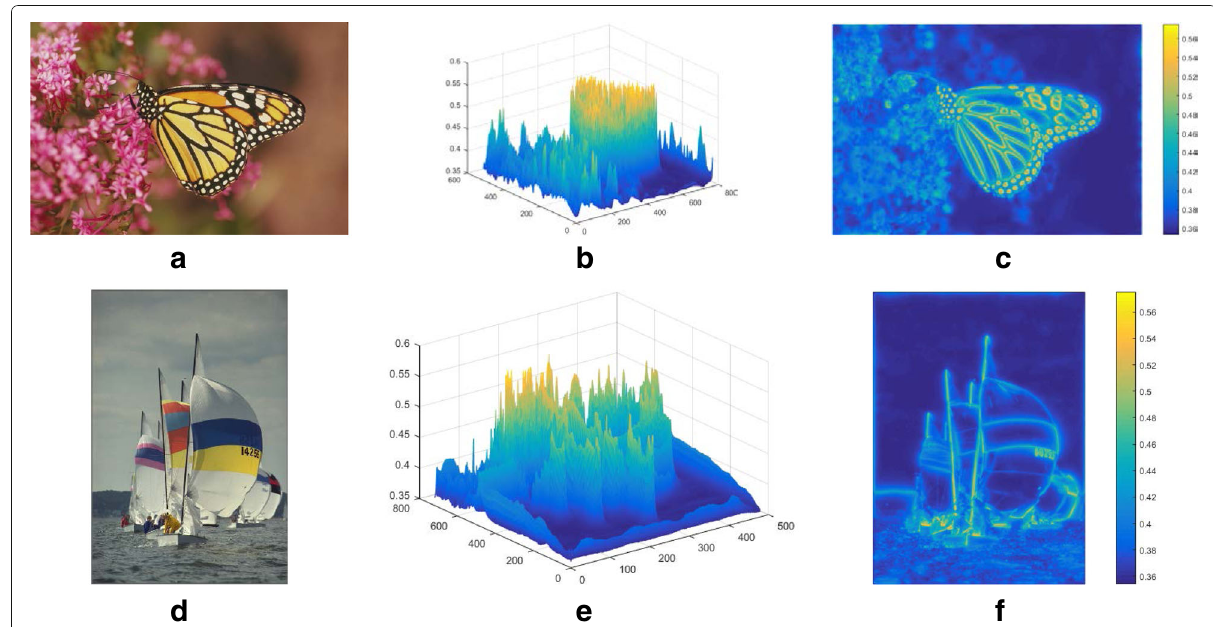
Fig. 3 Twosampleimagesusedforthe weight function. TheseimagesareextractedfromtheLIVEdatabase. a , d Reference image. b , e Three-dimensional surface of the weight function. c , f Rotate maps of the three-dimensional surface